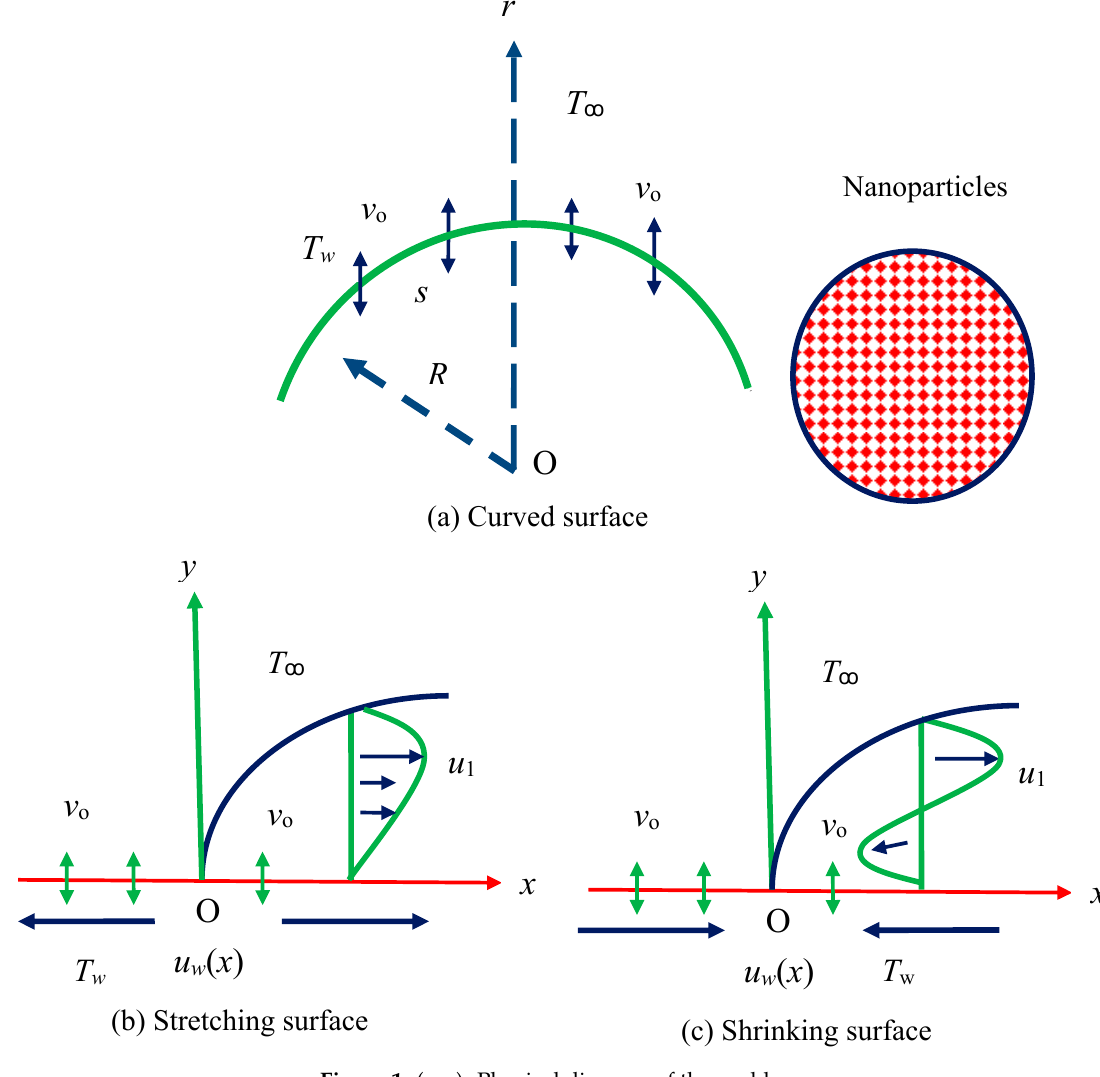
Figure 1. ( a – c ): Physical diagram of the